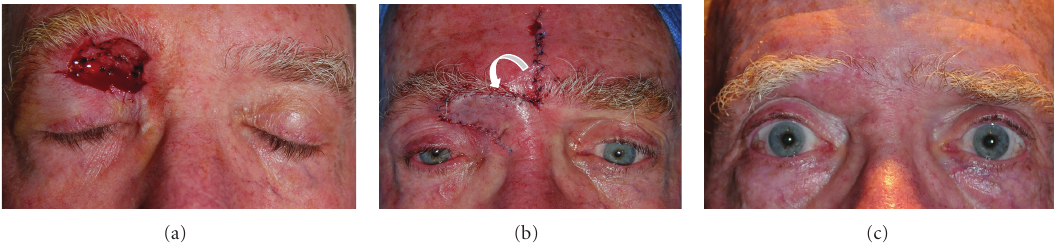
Figure 4: (a) A 67-year-old male status after Moh’s excision of basal cell carcinoma of the superomedial right upper eyelid creating a 3 × 2.5cm wound, which also included the preseptal and infrabrow region. (b) A glabellar flap is harvested centrally and rotated inferiorly and laterally to reconstruct the defect. Since the defect involved only the anterior lamella, no posterior lamella or muscle layer reconstruction was necessary. (c) 10 months postoperatively with an excellent